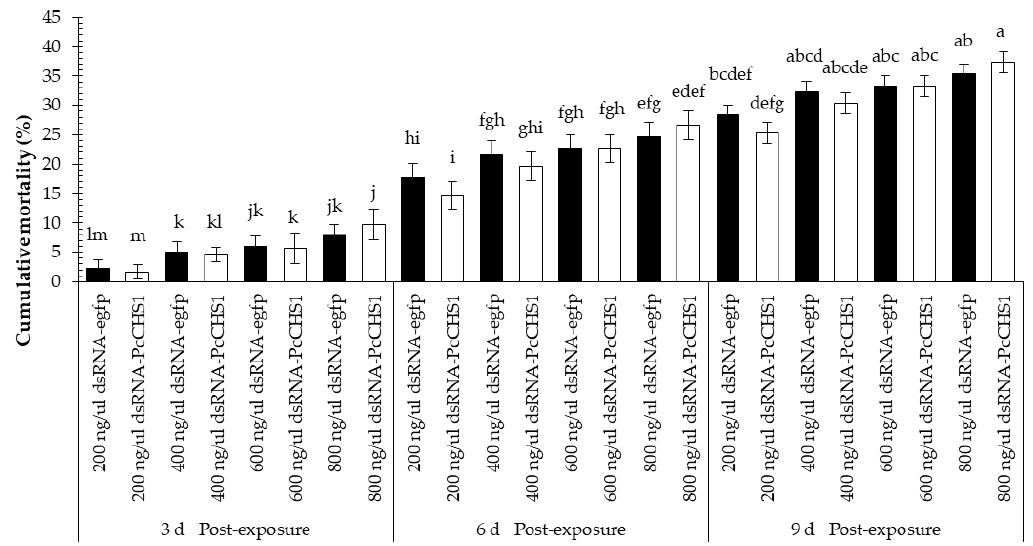
Figure 6. Time–mortality response of P. citri adults upon exposure to the target gene ( PcCHS1 ) dsRNA- PcCHS1 , compared to the control group (dsRNA- egfp ). The values are the means of three independent replicates ( n = 50 per replicate). The mortality response over time was analyzed by a repeated measures ANOVA, and significant differences among the means were analyzed by a Fisher’s LSD test (α = 0.05). Different small case letters on the bars showing significant difference between the treatments.